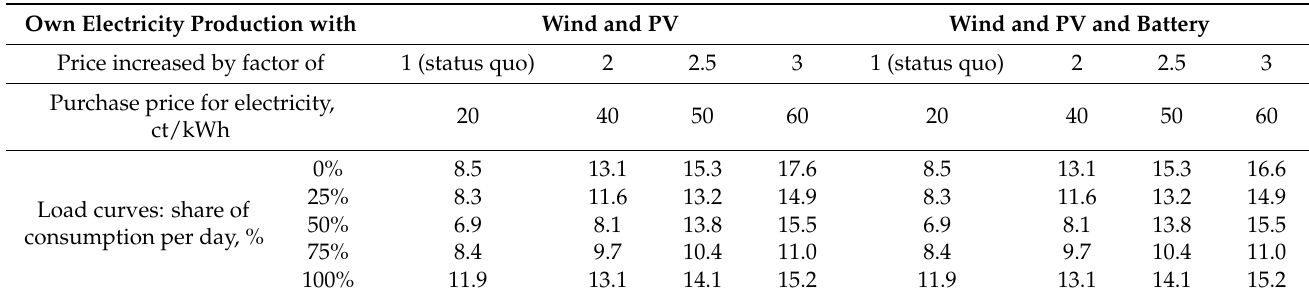
Table 9. Costs of farm’s power supply with combined PV and wind, ct/kWh.